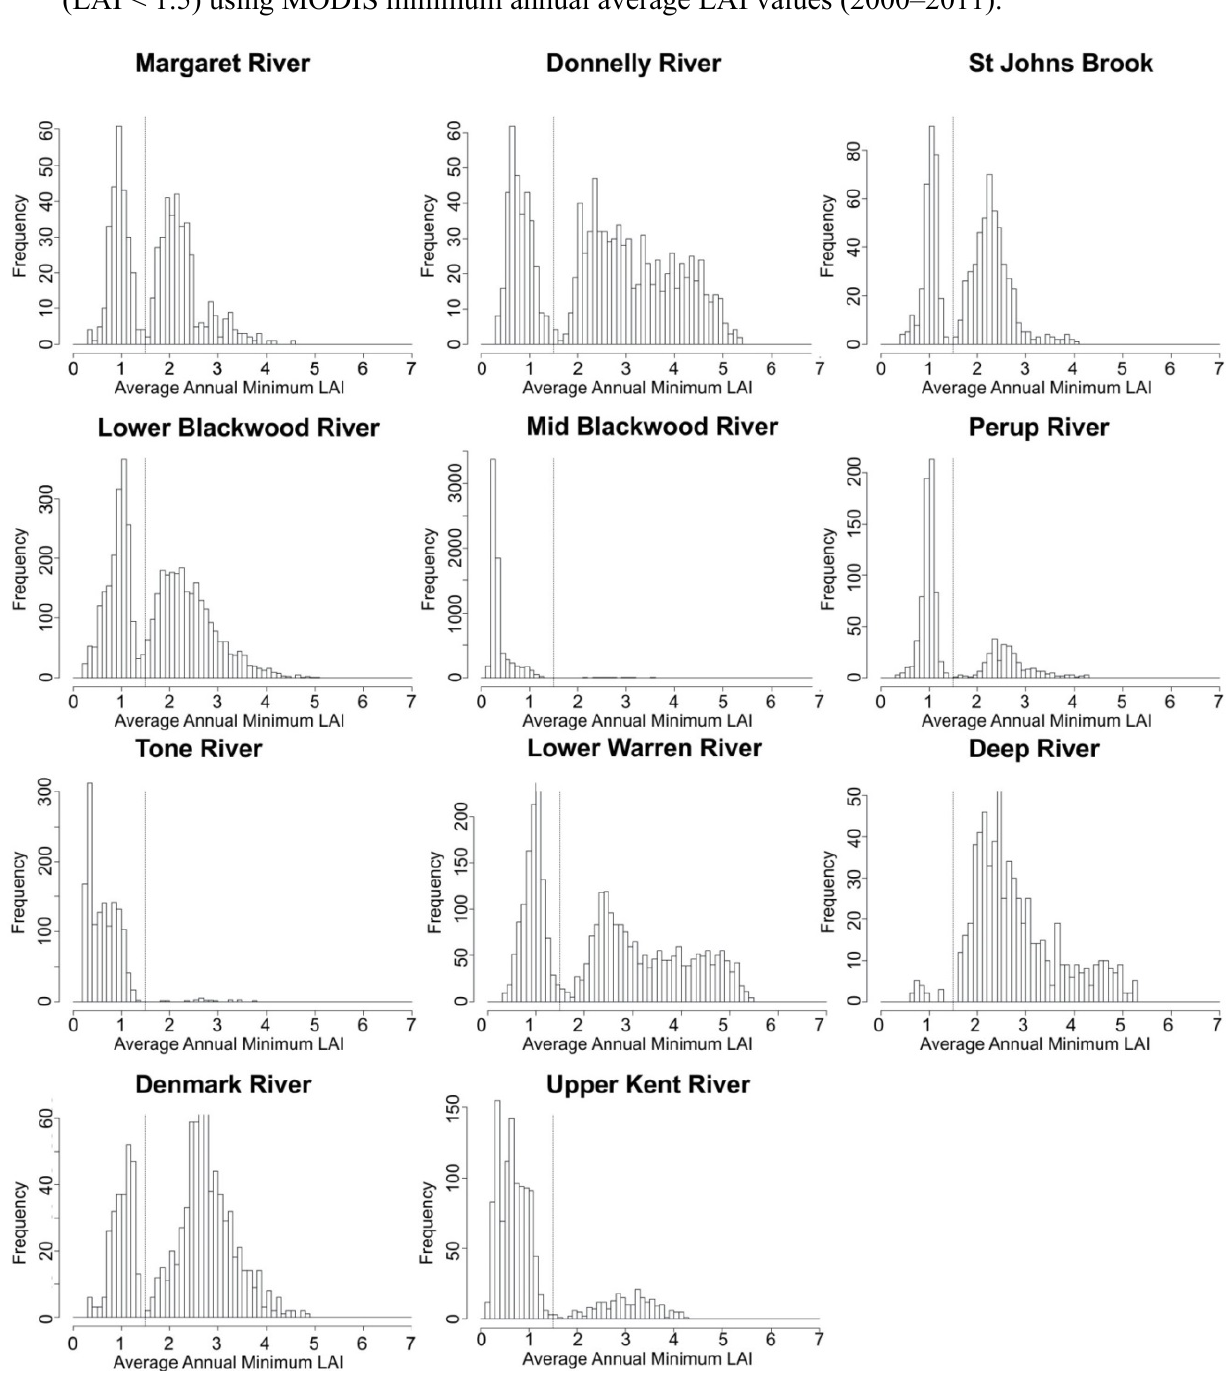
Figure 2. Separation of land use in each catchment into ‘forest’ (LAI > 1.5) and ‘grassland (LAI < 1.5) using MODIS minimum annual average LAI values